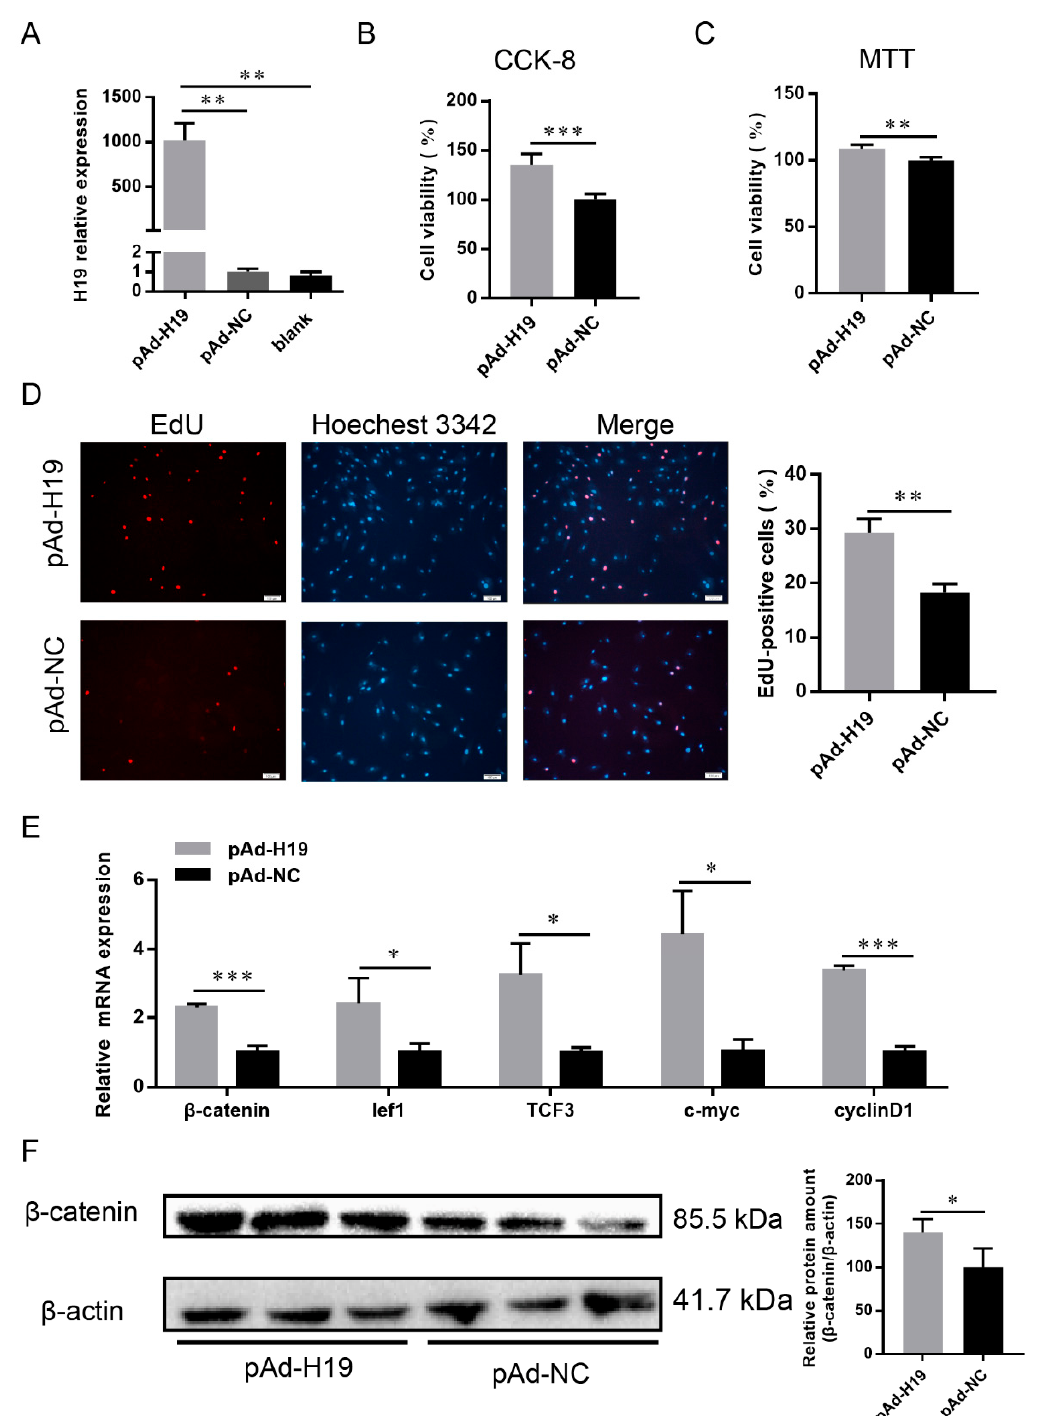
Figure 2. H19 promotes dermal papilla cells proliferation. ( A ) RT-qPCR of H19 expression after transfection with adenoviruses pAd-H19, pAd-NC, and blank control. ( B ) Cell viability was determined by CCK-8 assay. ( C ) Cell viability was determined by MTT assay. ( D ) Cell viability was determined by EdU assay, red represents EdU staining and blue represents cell nuclei stained with Hoechst 33342; the scale bar stands for 100 μ m. ( E ) Relative mRNA level of Wnt signaling pathway and downstream factors as detected by RT-qPCR. ( F ) β -catenin protein was detected by Western blot. The data were presented as mean ± SEM for 3 biological replicates, * p < 0.05, ** p < 0.01, *** p < 0.001.